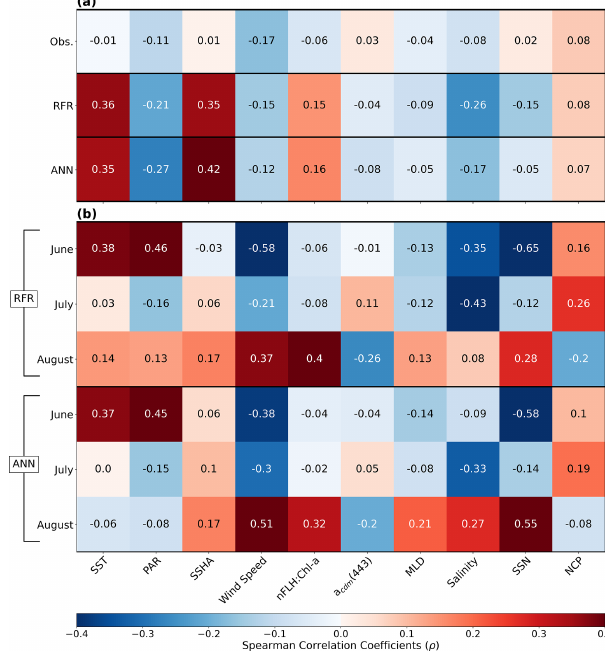
Figure 7. Heatmap of Spearman rank correlations ( ρ ). (a) Correla- tions of pooled data (June–August) for DMS observations (Obs.), RFR and ANN predictions per variable. (b) Correlations per month for the RFR and ANN DMS predictions. All model correlations are computed on the 1000-model ensembles.